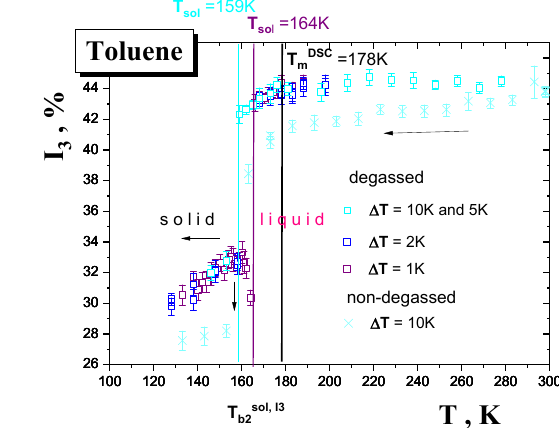
Figure 5. o-Ps annihilation parameters for TOL during various cooling runs on the degassed TOL sample: (i) cooling from RT with ∆ T = 10K down to 180 K close to T m,onDSC = 178 K and then with ∆ T = 5 K down to 145 K (light blue squares); (ii) cooling from 200 K with ∆ T = 5 K down to125 K (blue squares); (iii) cooling from 190 K with ∆ T =1 K down to 135 K (violet squares) on the non-degassed TOL; iv) cooling from RT, first with ∆ T = 10K down to 130 K (light blue crosses). The characteristic PALS temperature of the change in the liquid state T b1liq, τ 3 , of solidification T sol ( ∆ T ) and the melting point at T m,onDSC from DSC and finally of the change in the solid state T b2sol,I3 ≅ 158 K are marked in the upper or lower T scales, respectively.